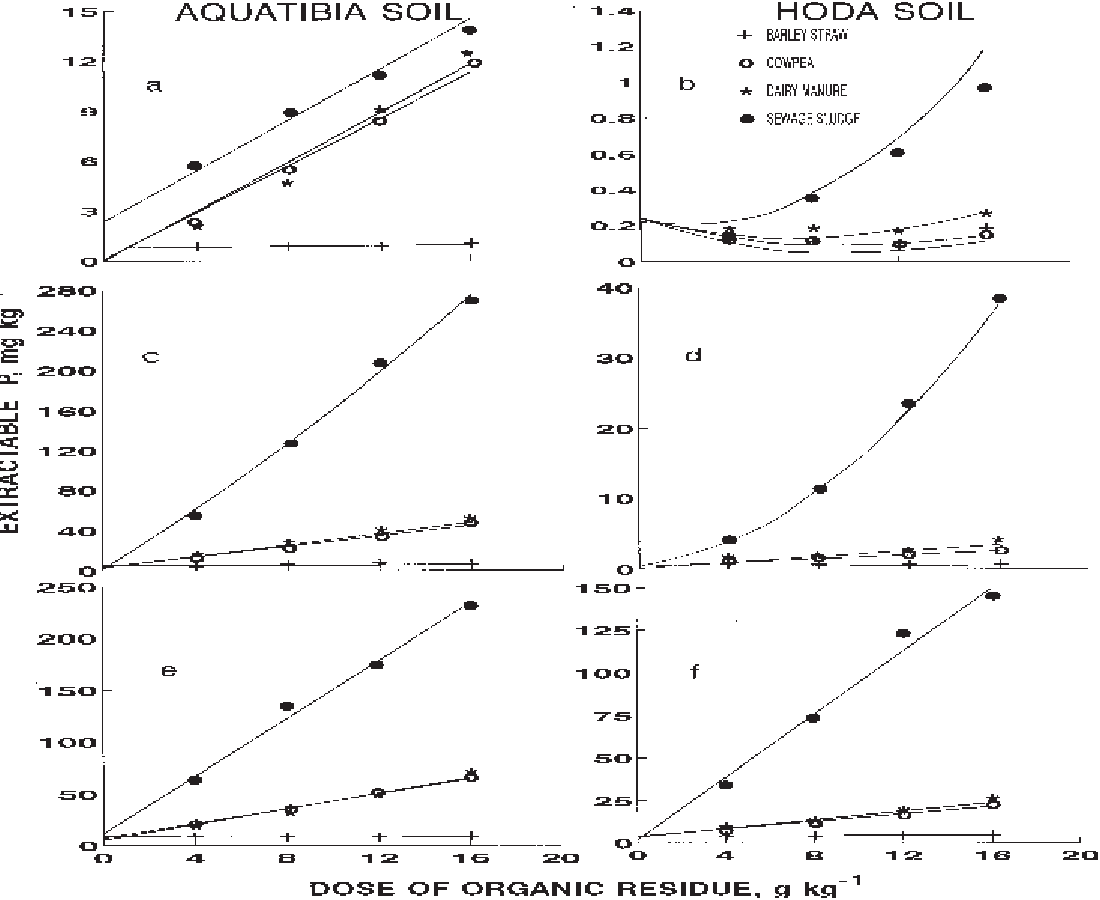
Figure 1. Amounts of phosphorus extracted by the water (a and b), Mehlich 1 (c and d) and resin (e and f) methods, from two soils previously treated with increasing amounts of organic residues and